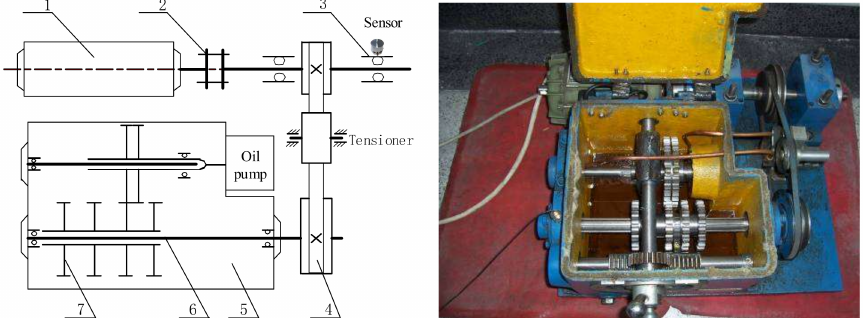
Figure 22. Fault simulation device for rolling bearing and gear. 1—motor, 2—coupler, 3—replaceable rolling bearing with 6207, 4—belt pulley, 5—device box, 6—transmission shaft,